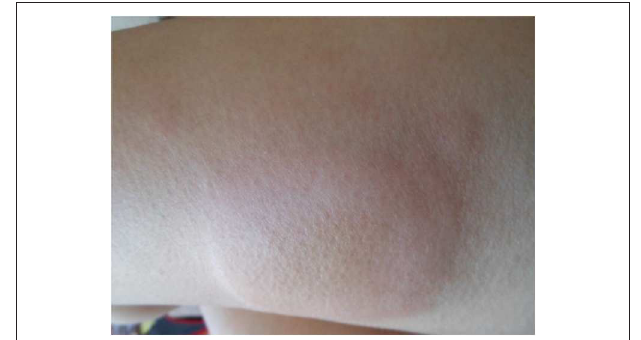
FIGURE 2 | Example of an injection site reaction with